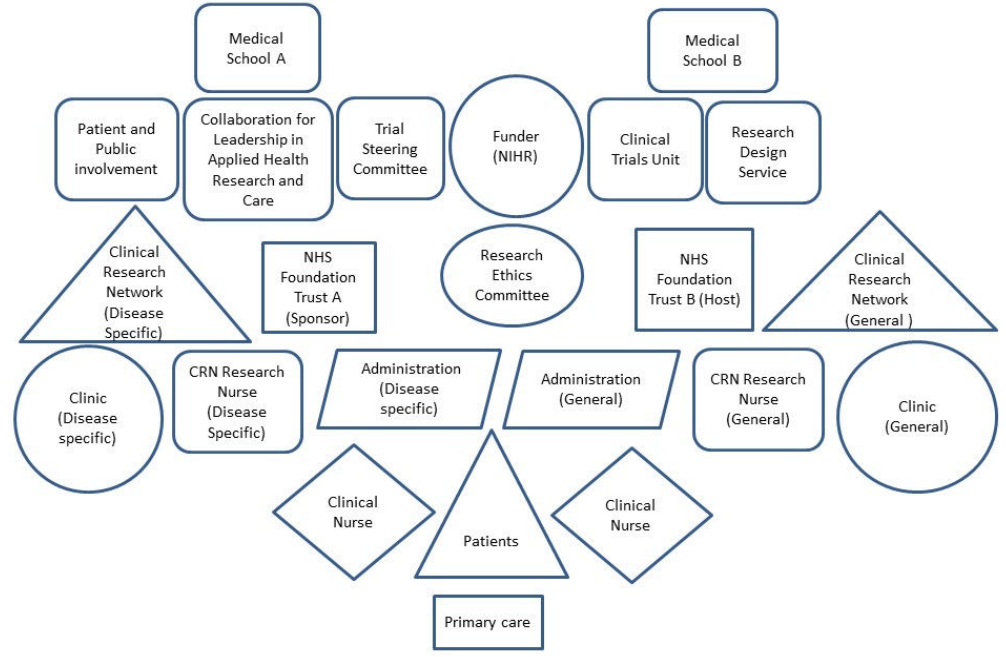
Figure 1. Organogram of clinical and research organizations at both